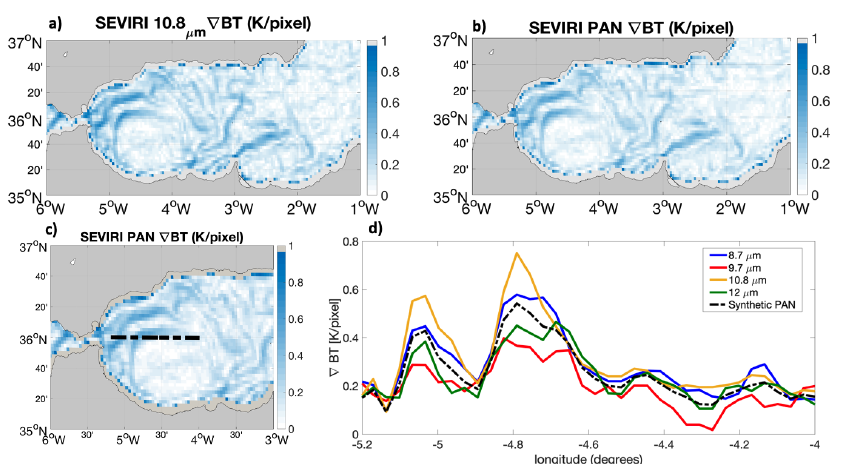
Figure 7. ( a ) Sobel spatial gradients of BT for SEVIRI channel #9. ( b ) Sobel spatial gradients of BT from the SEVIRI simulated PAN. ( c ) Zoom over the Alboran Gyre area, depicting in detail the 1D transect for the extraction of gradient magnitudes at 36 ◦ N. ( d ) Gradient magnitudes at 36 ◦ N: blue, red, yellow, green and dashed black lines, respectively, refer to gradient magnitudes seen by the 8.7, 9.7, 10.8, 12.0 µ m and synthetic PAN